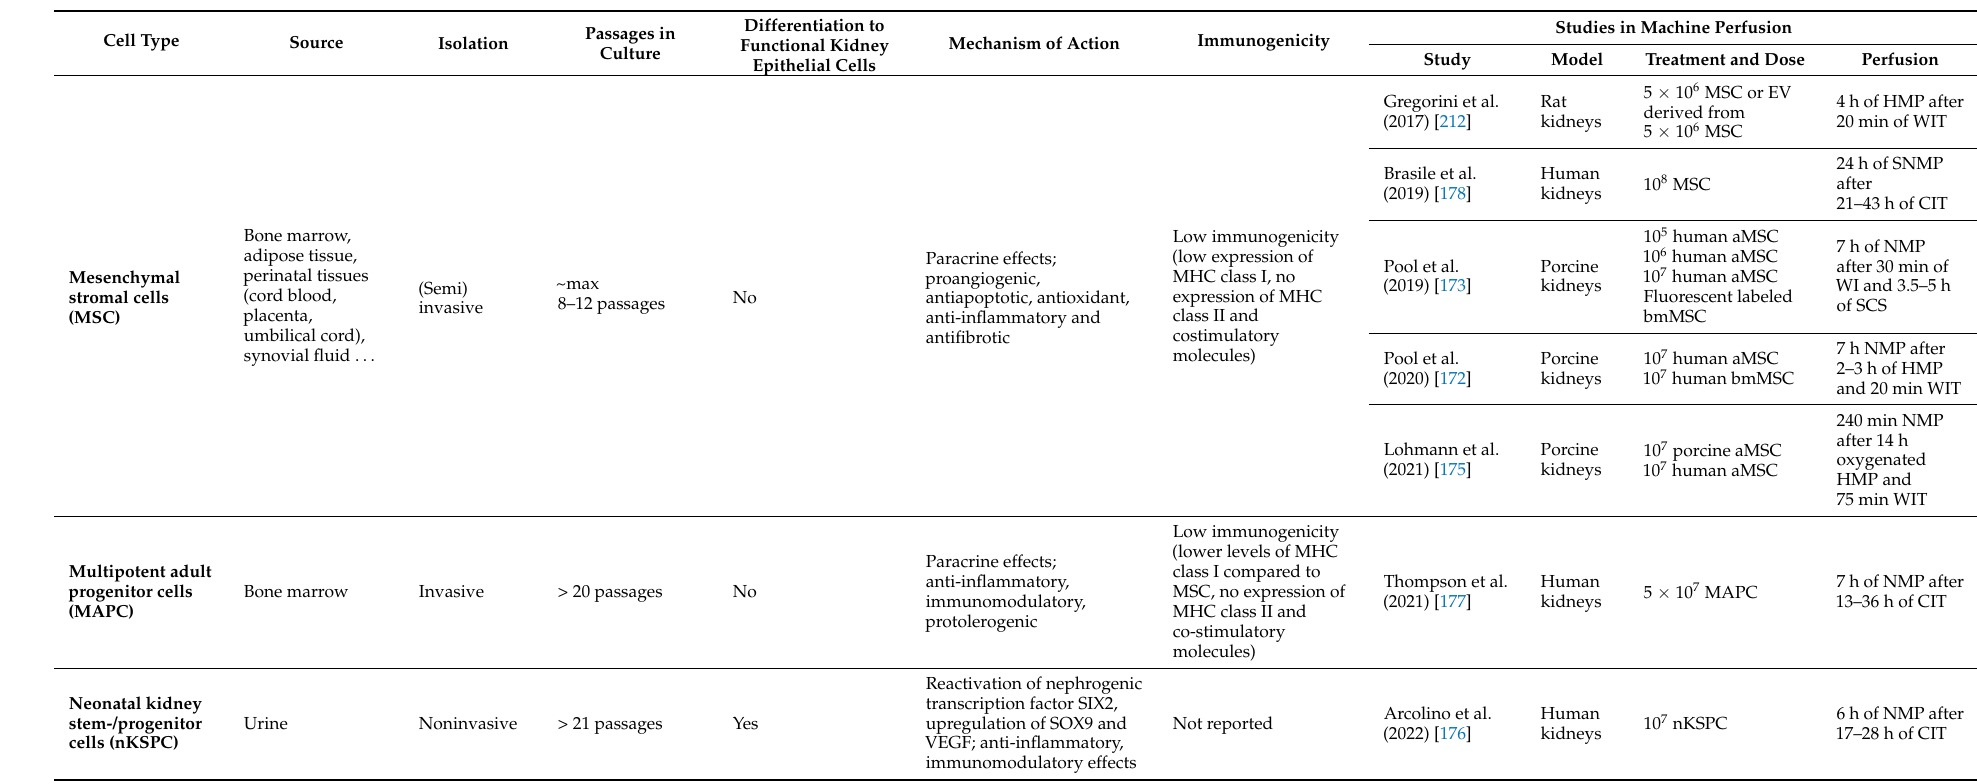
Table 2. Types of cell therapy for kidney graft reconditioning during machine perfusion. aMSC, adipose tissue-derived MSC; bmMSC, bone marrow-derived MSC; CIT, cold ischemic time; EV, extracellular vesicles; HMP, hypothermic machine perfusion; MHC, major histocompatibility complex; NMP, normothermic machine perfusion; WIT, warm ischemic